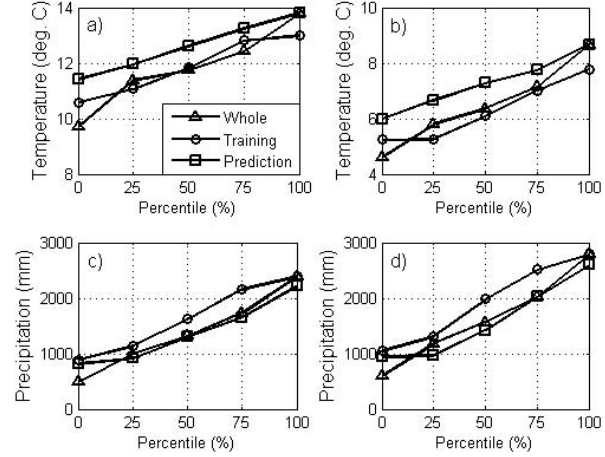
Fig. 1. Location and elevation ranges of the North Fork of the American River Basin (NFARB) as well as locations of streamflow and snow observational stations used in the current study.